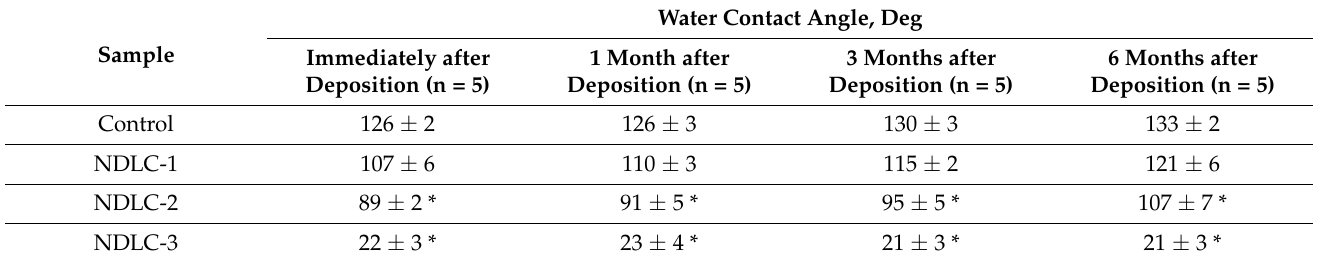
Table 2. Water contact angles of the fabricated samples .